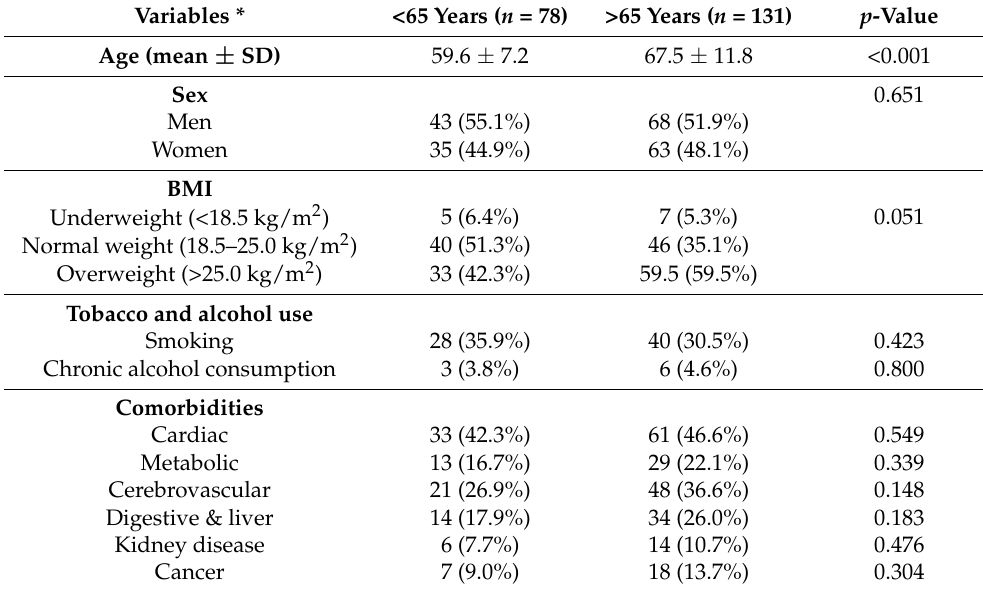
Table 1. Background characteristics of the study